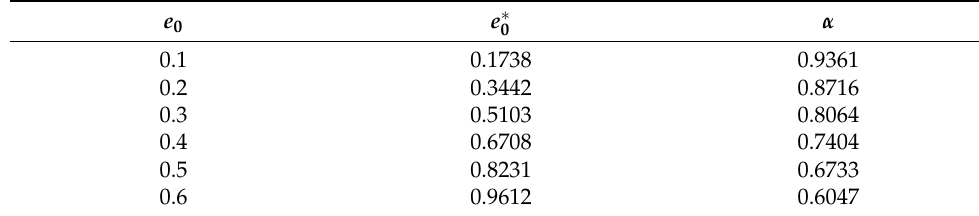
Table 1. Porosity coefficients for different